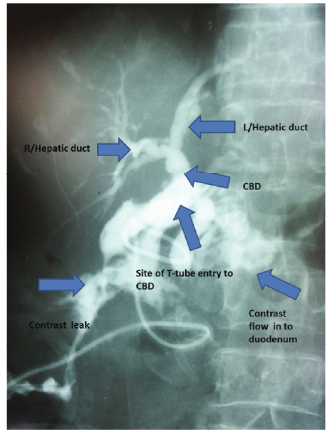
Figure 2: Postoperative T-tube cholangiogram showing biliary anatomy and contrast